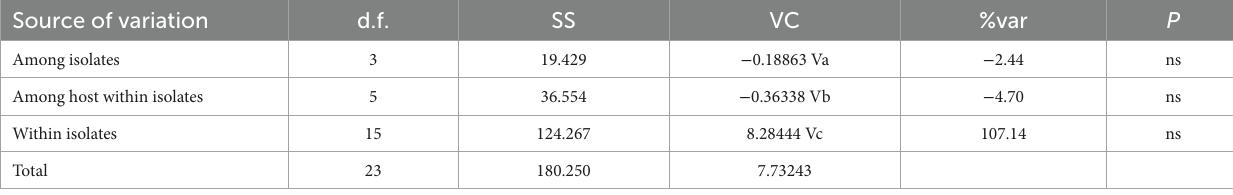
TABLE 7 Analysis of molecular variance (AMOVA) of Pseudokabatana alburnus based on Rpb1 gene. Source of